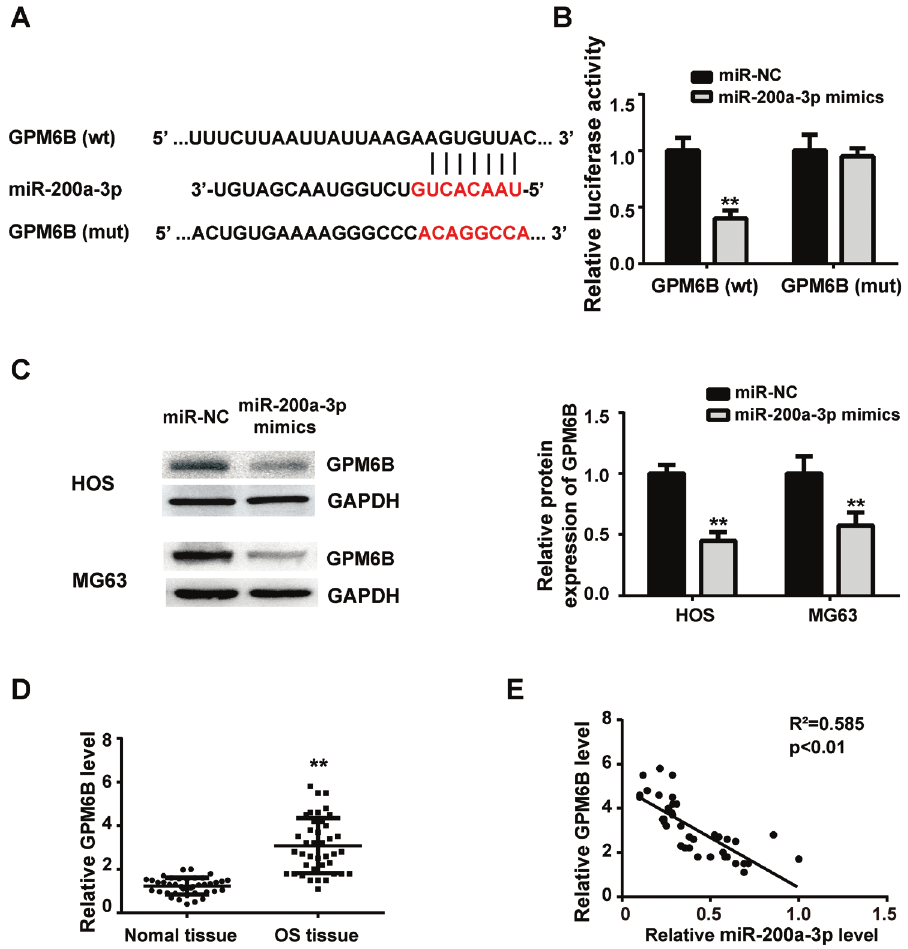
Fig. 5. miR-200a-3p targeted GPM6B directly. (a) Binding sites between DLX6-AS1 and miR-200a-3p via TargetScan. (b) The mutual effect between miR-200a-3p and GPM6B in HEK-293T cells was confirmed by a luciferase assay. (c) The protein expres- sion of GPM6B was estimated with miR-200a-3p mimics transfection. (d) The mRNA expression of GPM6B in OS tissues and adjacent normal tissues was measured via RT-qPCR. (e) miR-200a-3p had a negative correlation with GPM6B. NC, negative control. ** P < 0.01, versus miR-NC or normal